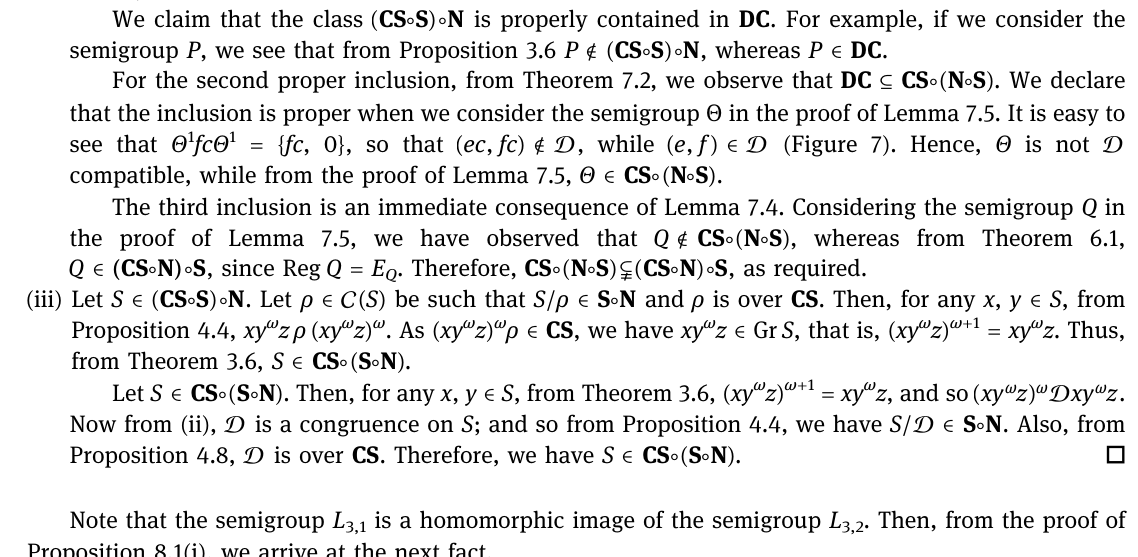
( Figure 7 ) . Hence, Θ is not